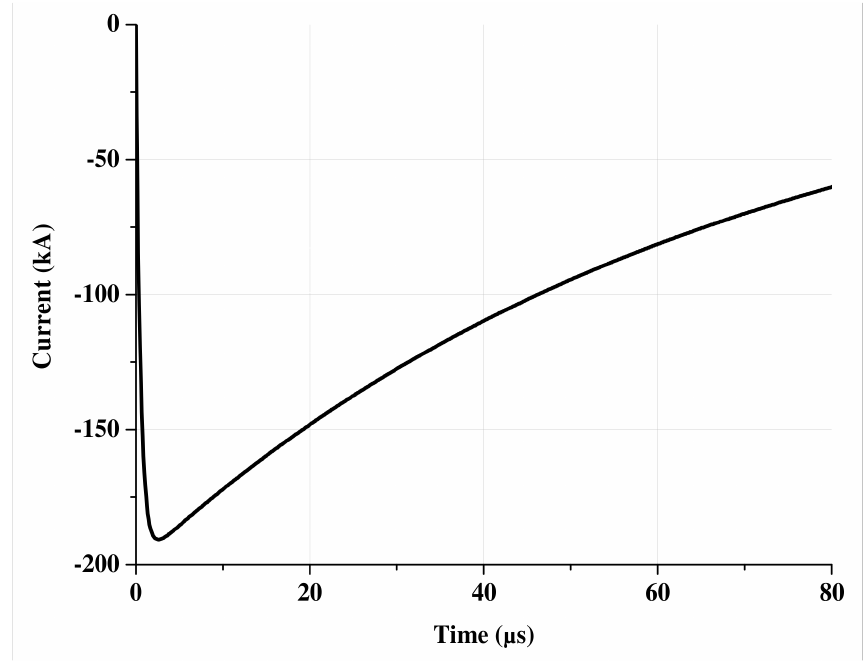
Figure 8. Injected lightning current